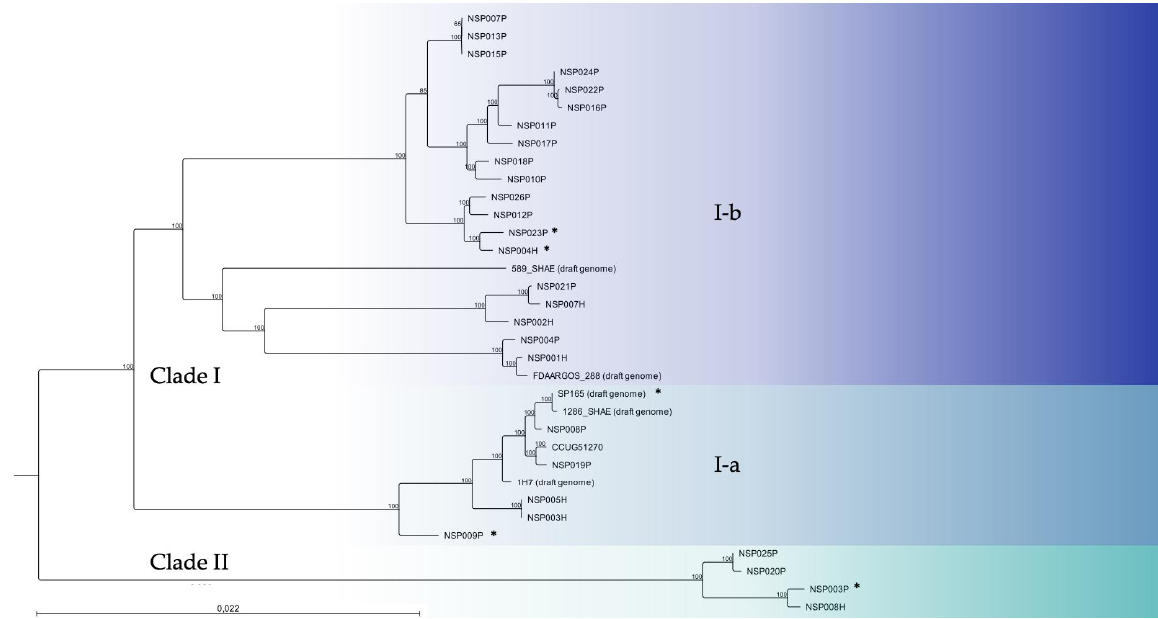
Figure 1. Whole-genome phylogenetic tree of 29 S. pettenkoferi clinical isolates aligned with five available S. pettenkoferi draft genomes and the CIP 107711 reference strain. Neighbour-joining tree was generated using CLC Genomics Workbench 22.0.2 (QIAGEN Bioinformatics). Numbers at nodes indicate the percentage of bootstrap based on analysis of 100 resampled datasets. The scale bar represents 2.2% sequence divergence. Strains are coloured according to their phylogenetic group (clade). Clade I includes subclade I-a (light blue) and I-b (dark blue). Clade II, green. *, denotes the isolates investigated in depth in this paper.